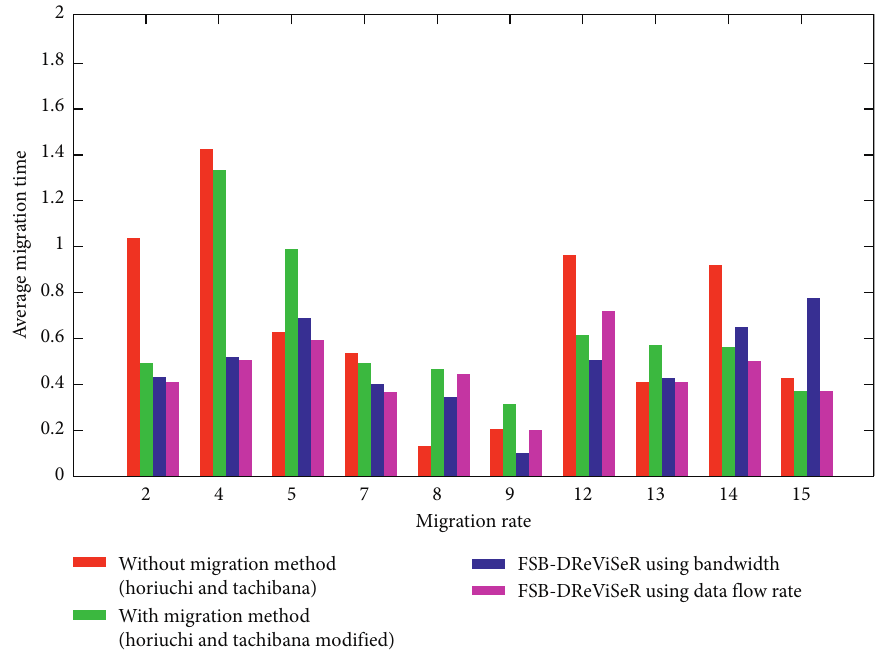
Figure 13: Average migration time versus migration rate for a 60-node network.